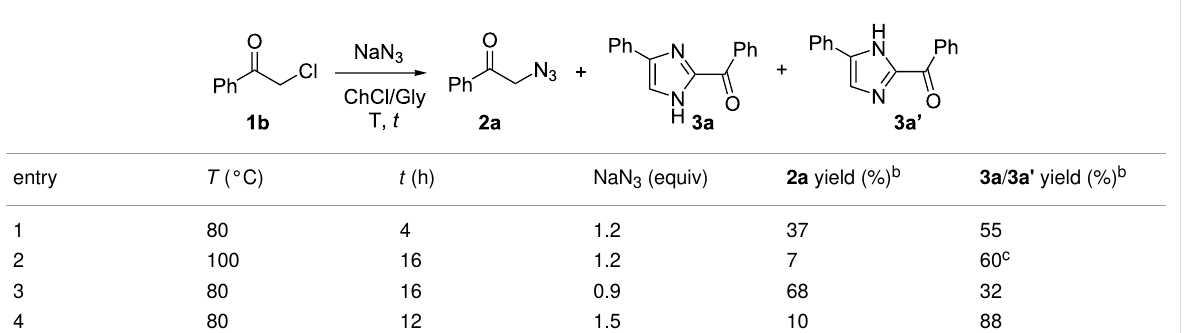
Table 1: Optimization of the reaction conditions for the synthesis of 3a / 3a' .